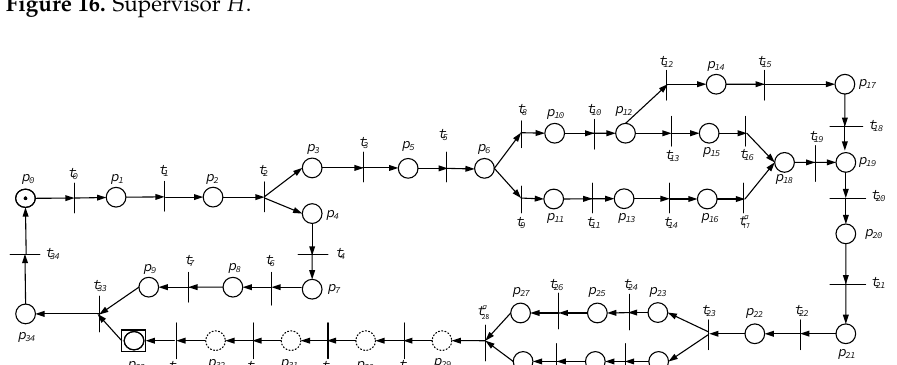
Figure 16. Supervisor H .